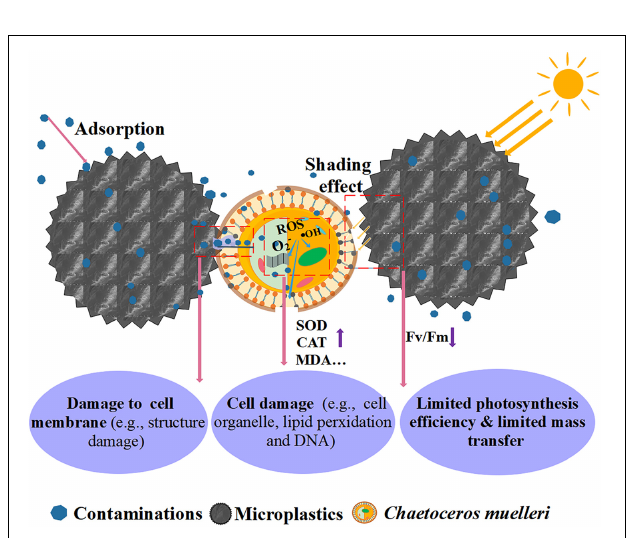
FIGURE 8 | Toxicity mechanism of microplastics on C. muelleri